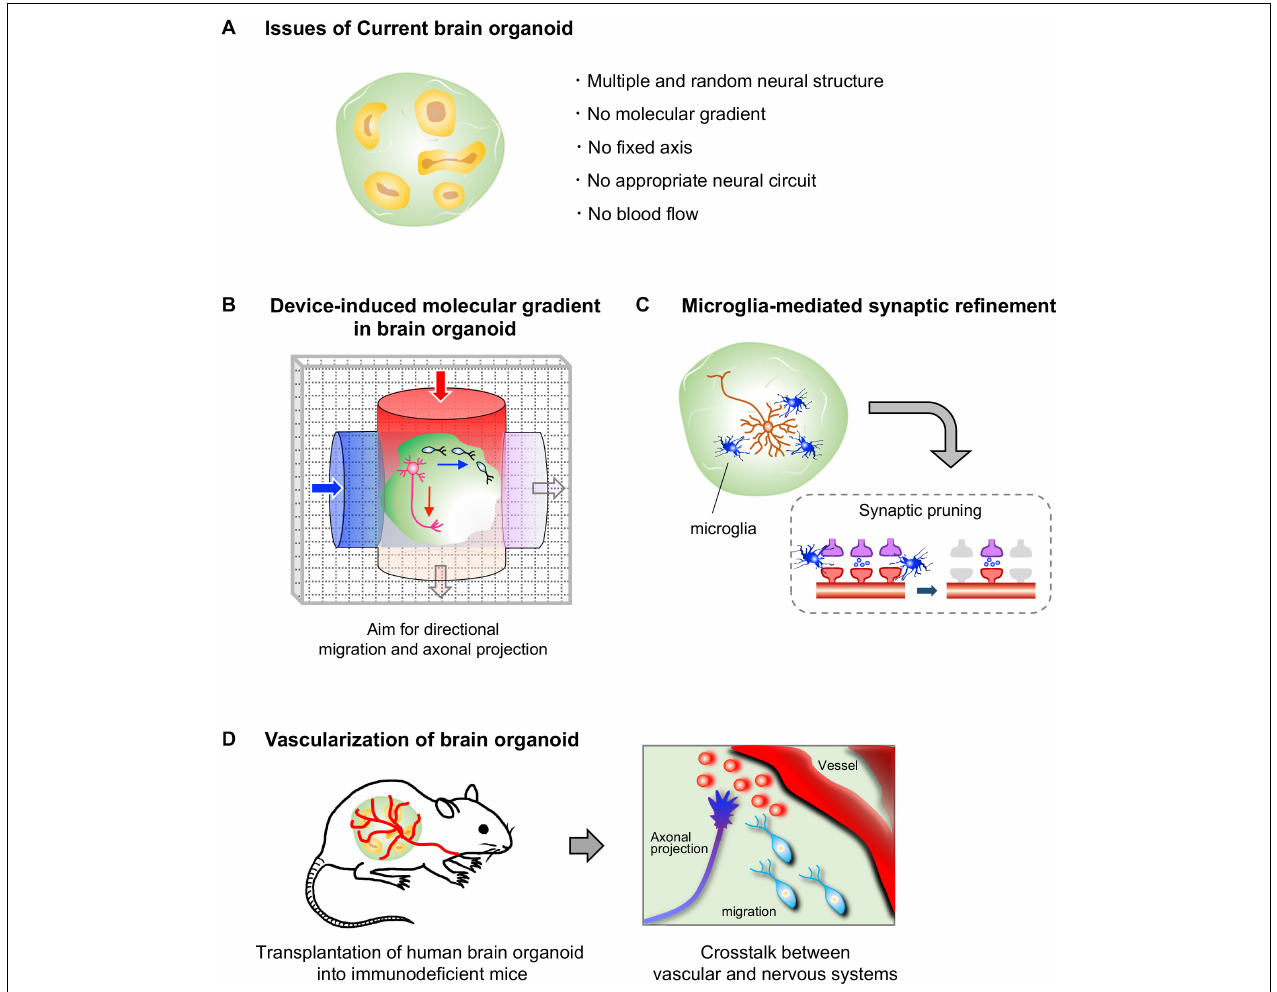
FIGURE 2 | Current limitations to brain organoids and prospective approaches. (A) Human brain organoids generated by current protocols lack a self-generating molecular gradient, as well as blood flow. These limitations hamper the formation of a structural axis assembled by orderly-positioned brain components; therefore the formation of appropriate neural circuits in brain organoids is impeded. (B) A device that generates molecular gradients would be effective in inducing directional migration and axonal projections, as well as a structural axis. Embedding of cells that secrete a certain molecule such as morphogens may also help to generate molecular gradients in brain organoids (not depicted). (C) Human brain organoids that contain microglial cells may allow us to analyze a process of synaptic refinement, such as microglia-mediated synapse pruning, in human neural circuits. (D) The transplantation of human brain organoids into highly vascularized organs of immunodeficient mice may allow us to analyze vascular system-mediated neural circuit formation in